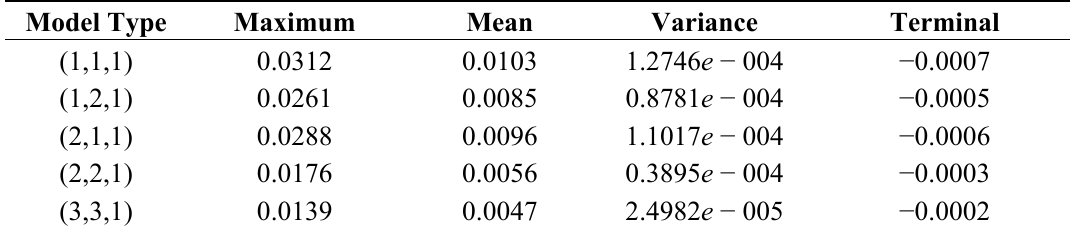
Table 5. The statistic list of the absolute SOC estimation error and terminal SOC error. Model Type